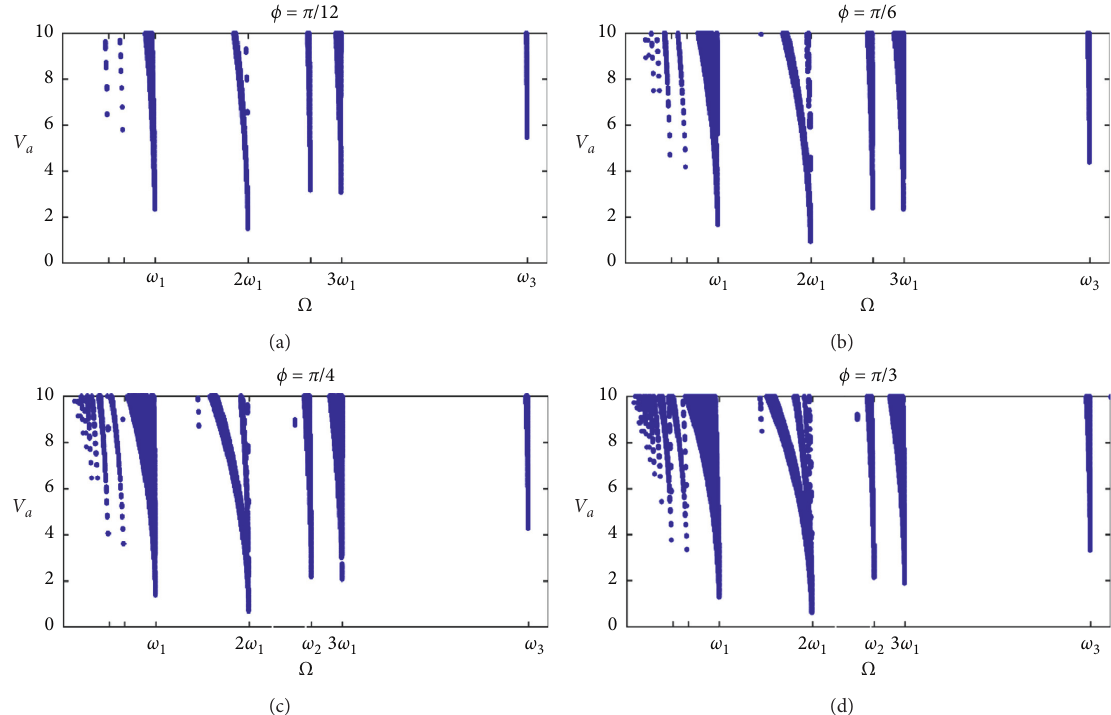
Figure 4: The unstable region of the system under different electrode spans.